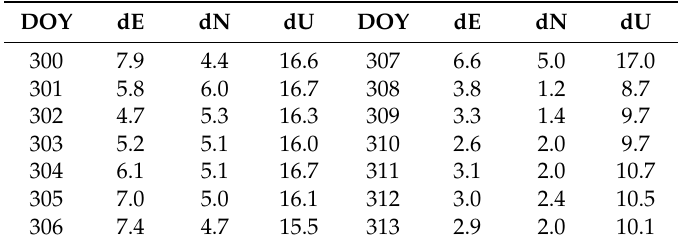
Table 8. Comparison of BDS and GPS static solutions in multipath-rich station (unit: mm). dE, dN and dU represent the difference between BDS and GPS static baseline